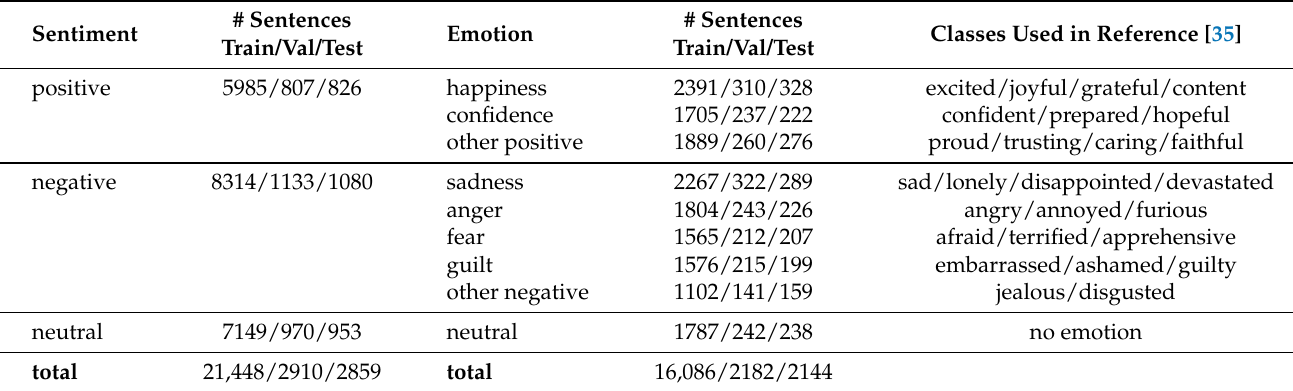
Table 1. Class aggregations and corpus statistics (# sentences) for sentiment and emotion setups.